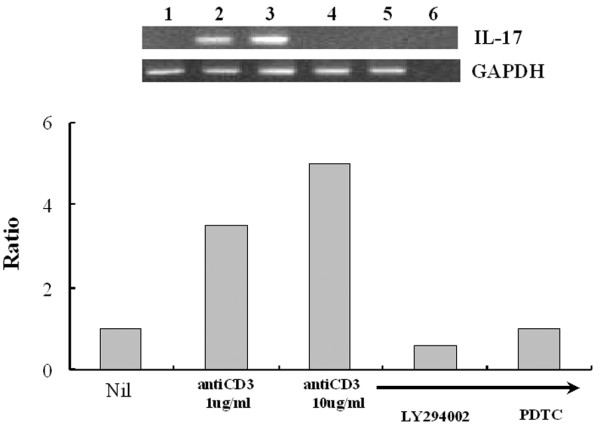
Effects of LY294002 or pyrrolidine dithiocarbamate (PDTC) on anti-CD3 antibody-triggered interleukin (IL)-17 mRNA expression by peripheral blood mononuclear cells (PBMC) from patients with rheumatoid arthritis. PBMC were cultured with medium only (lane 1), anti-CD3 antibody (1 μg/ml; lane 2), anti-CD3 antibody (10 μg/ml; lane 3), anti-CD3 antibody (10 μg/ml) plus LY294002 (20 μM; lane 4) or anti-CD3 antibody (10 μg/ml) plus PDTC (300 μM; lane 5) for 12 hours; lane 6 shows a negative control. Total RNA (2 μg) was used for cDNA synthesis in a volume of 20 μl; 1 μl of the synthesized cDNA was used for reverse transcription–polymerase chain reaction as described. PCR reaction product (25 μl) was separated on an agarose gel containing ethidium bromide. The relative intensities of the bands were revealed under UV radiation.